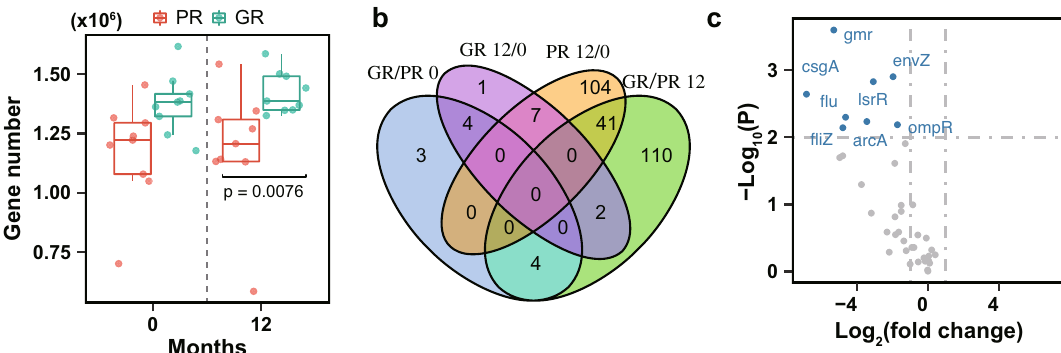
Fig. 3 Potential function alterations of the gut microbiota after supplementation with L. reuteri . a Gene number of the gut microbiota in the PR ( n = 9) and GR ( n = 9) groups at the two time points. 20 million reads from each sample were sampled in order to rarefy the reads to the same depth of sequencing. The blue and red colors indicate the GR and PR groups, respectively. The upper quartile, median and lower quartile are shown in the box plot. b The Venn diagram shows differential KOs between the GR ( n = 9) and PR ( n = 9) groups or between baseline and 12 months (Adjusted P -value < 0.1 by DESeq2). ‘ GR/PR 0 ’ and ‘ GR/PR 12 ’ denote the comparative analysis between the GR and PR groups at baseline and 12 months, respectively. ‘ GR 12/0 ’ and ‘ PR 12/0 ’ denote the comparative analysis between the two time points in the GR and PR groups, respectively. c The volcano plot displays the differential genes involved in bio fi lm formation ( Escherichia coli ) between the GR ( n = 9) and PR ( n = 9) groups at 12 months. The blue color indicates the differential genes; The horizontal and vertical dashed lines indicate P- value < 0.01 and |log 2 fold change | >1,